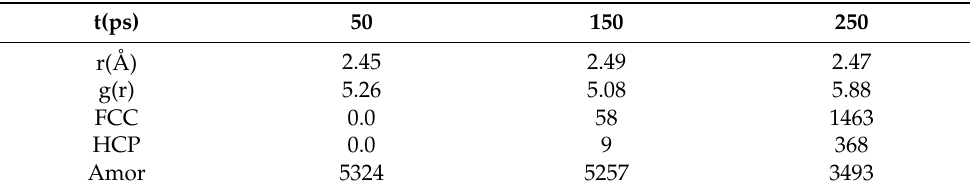
Figure 8. The crystallization process of NiAu 5324 alloy after different annealing time ( a ), the shape of NiAu alloy at t 1 = 50 ps ( b ), t 2 = 150 ps ( c ), t 3 = 250 ps ( d ). Table 4. The structural characteristics and number of structural units of NiAu 5324 alloy after different annealing times.